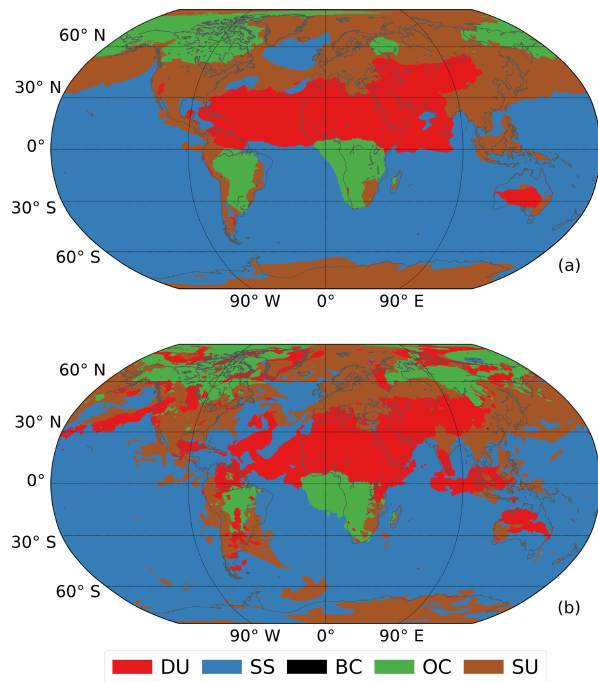
Figure 4. (a) Primary aerosol type selected for the month of July us- ing the MERRA-2 climatology. (b) Primary GEOS-5 aerosol type selected for 1 July 2016 00:00UTC. Aerosol types are dust (DU), sea salt (SS), black carbon (BC), organic carbon (OC), and sul- fate